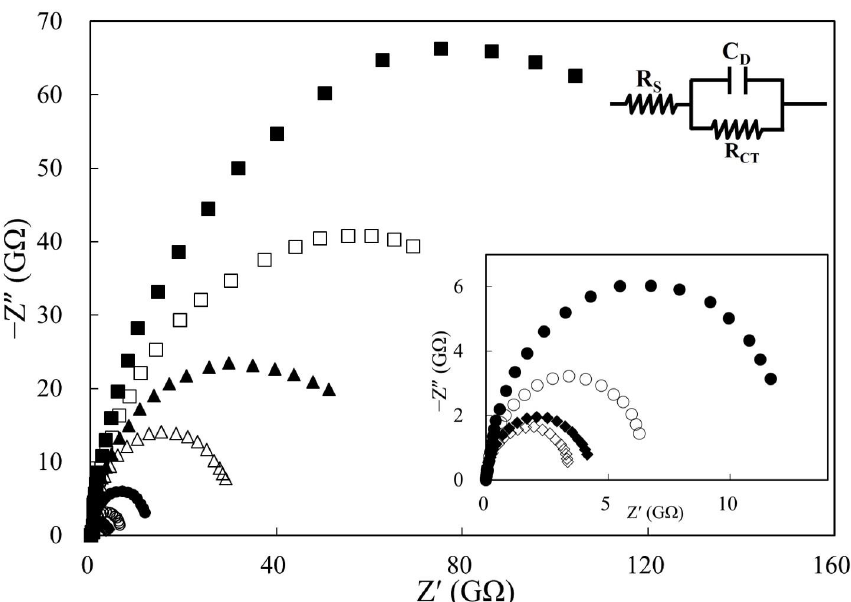
), 0.18 × 10 − 2 ( (cid:7) ), (cid:35)